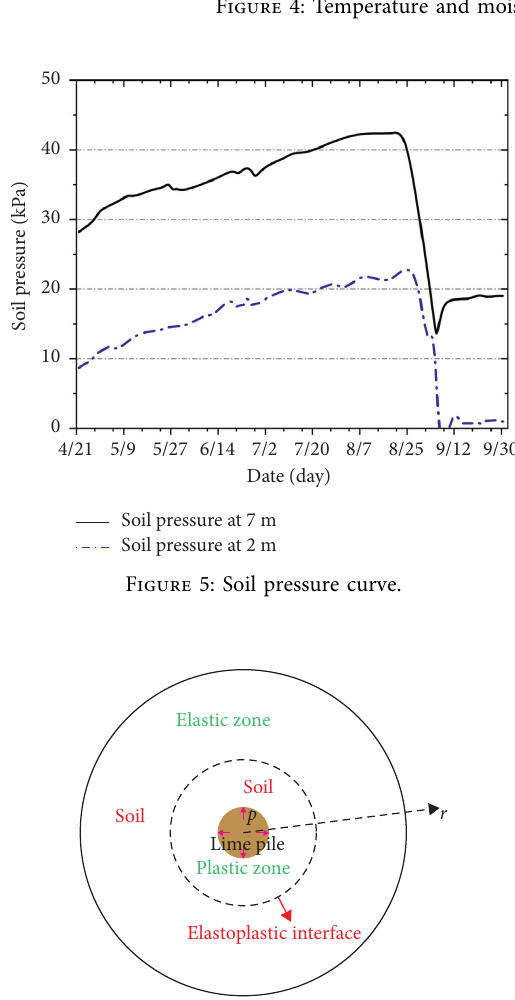
Figure 6: The model of column hole